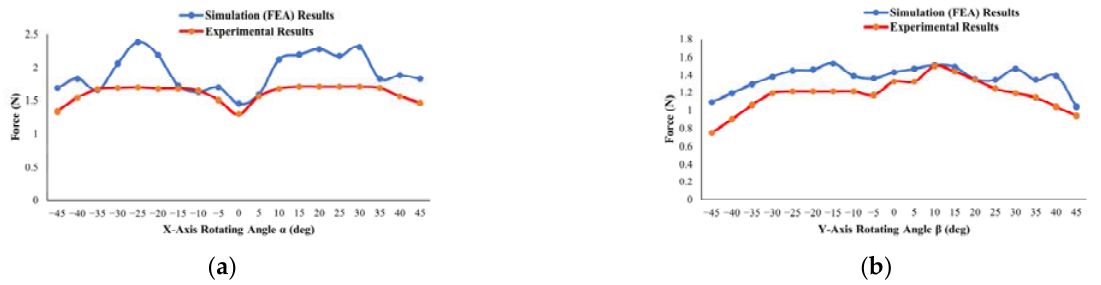
Figure 20. Measured and simulation results for force values of motor rotating around X ‐ axis from α = 0° to α = ±45° ( a ) and rotating around the Y ‐ axis from β = 0° to β = ±45° ( b ).